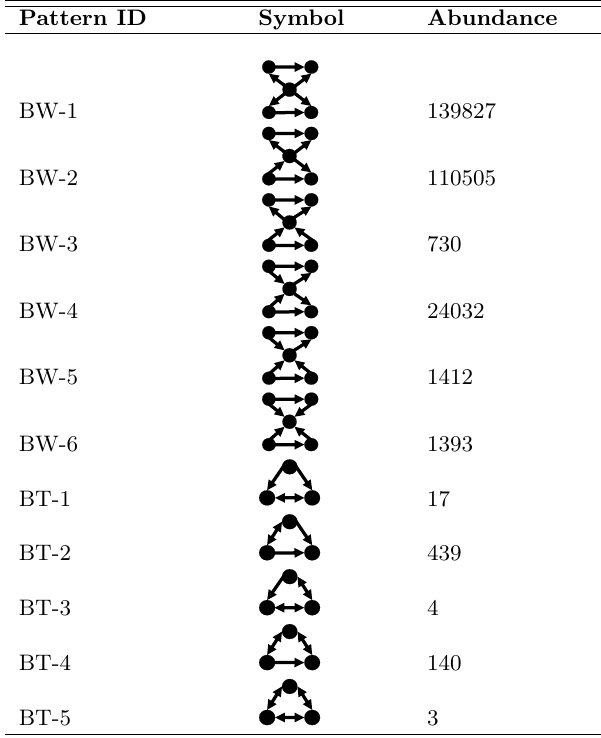
Table 1: Abundance of bow-tie and bi-triangle mo- tifs in E. coli transcriptional network.